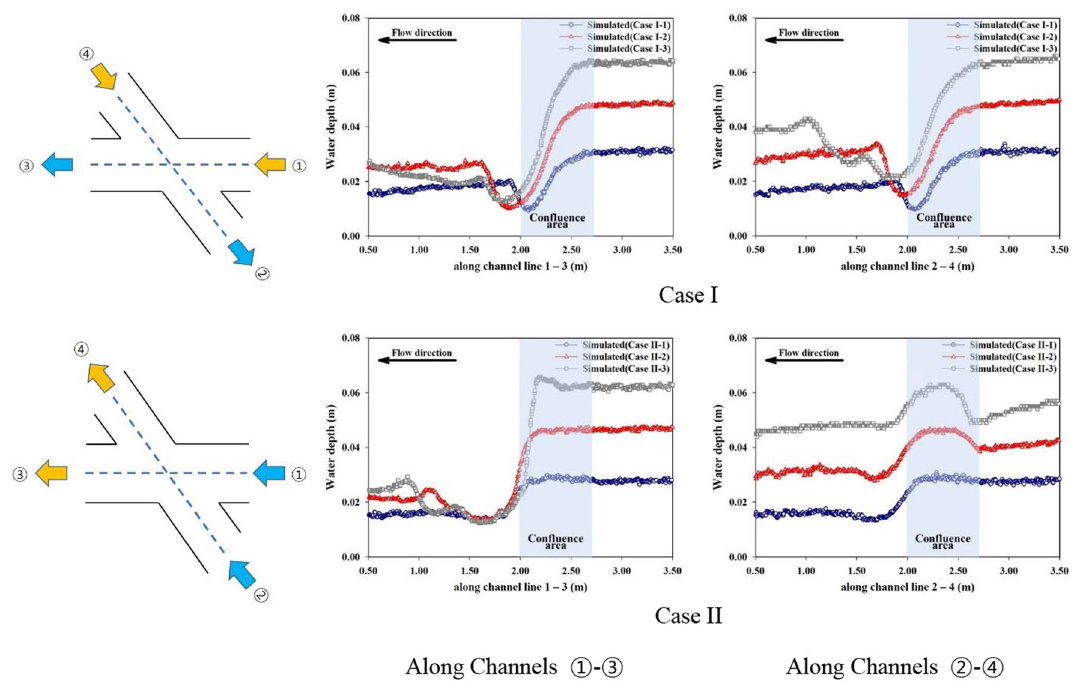
Fig. 12 Comparison of water-surface profiles along channels with increased inflow for Cases I and II